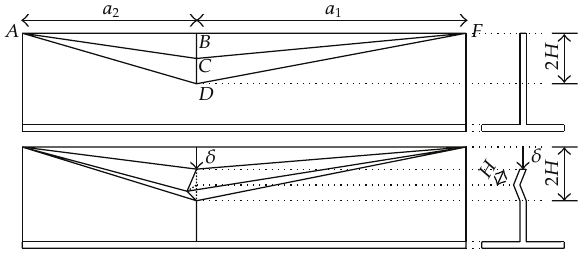
Figure 16: Displacements field assumed for